Question: What type of chart is this?
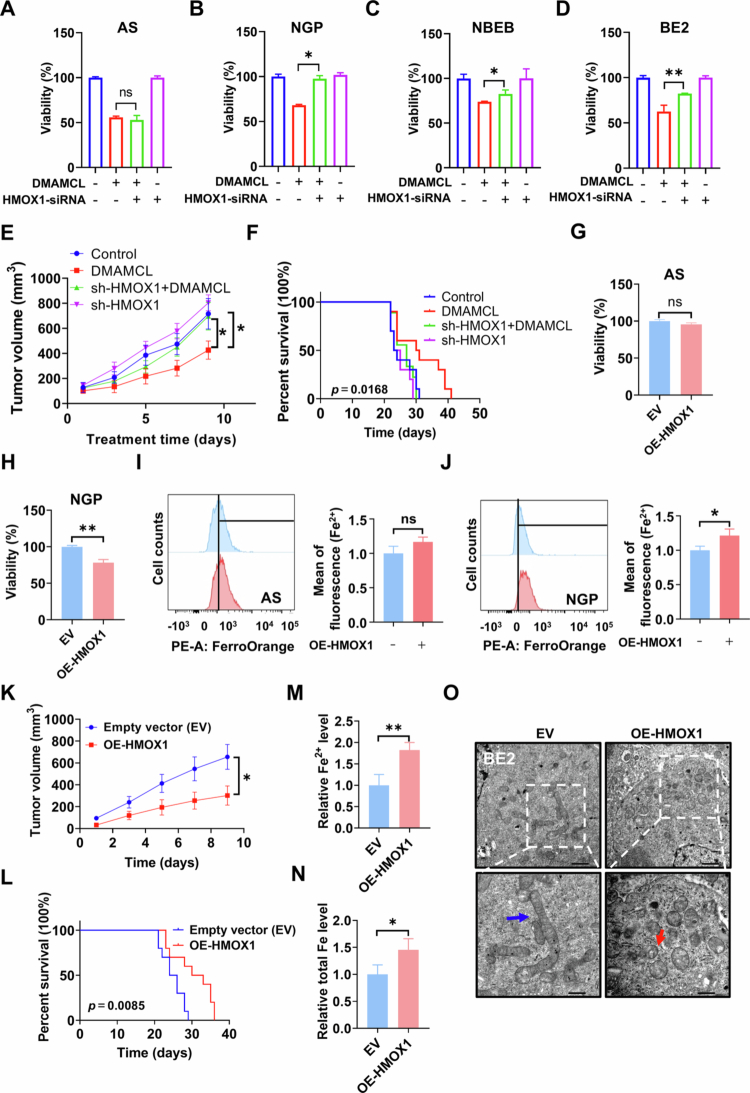
Answer: survival